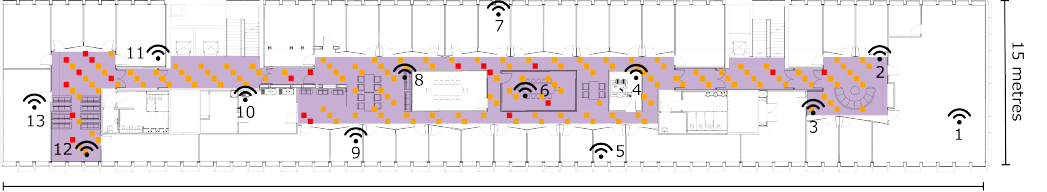
Figure 20. The RPs where the system makes misidentification. The orange dots indicate the RPs of testing data while the red indicate the misidentifications. Most misidentifications took place in areas surrounded by complicated interior changes.